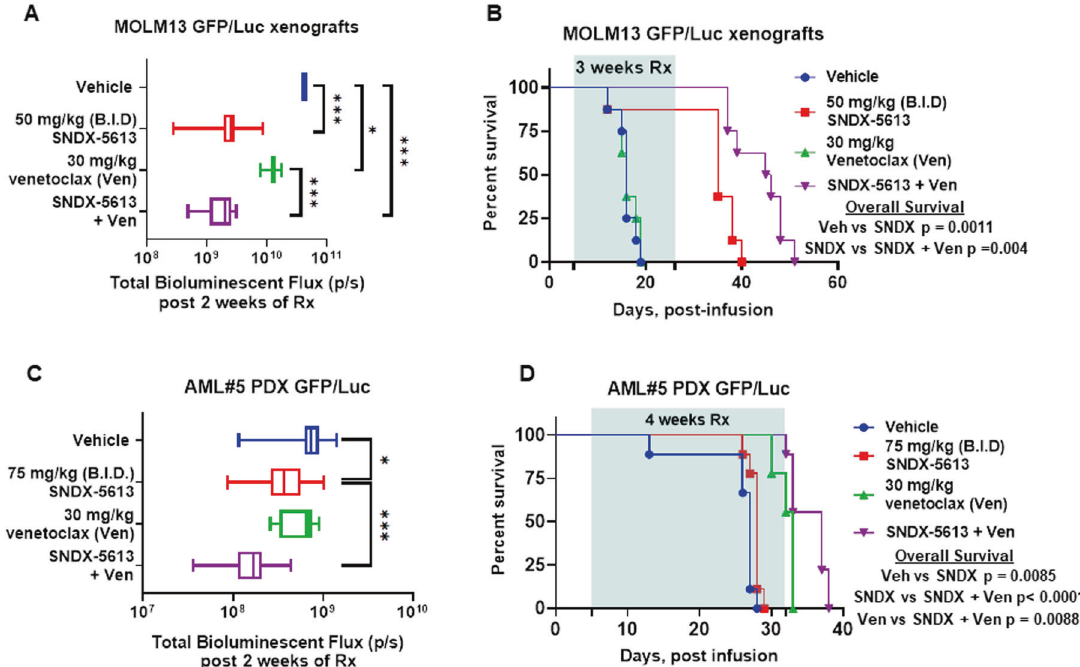
Fig. 7 Treatment with SNDX-5613 and venetoclax reduced leukemia burden and signi fi cantly improved survival of NSG mice bearing MLL1-r or mtNPM1 with mtFLT3 AML xenografts. A Total photon count [ fl ux] (determined by bioluminescent imaging) in NSG mice engrafted with MOLM13 GFP/Luc cells and treated for 2 weeks with SNDX-5613 and/or venetoclax at the indicated doses. B Kaplan – Meier survival plot of NSG mice engrafted with MOLM13 GFP/Luc cells and treated with 50 mg/kg of SNDX-5613 (B.I.D. ×5 days, P.O.) and/or 30 mg/ kg of venetoclax (daily ×5 days, P.O.) for 3 weeks. Signi fi cance was calculated by a Mantel – Cox log-rank test. C Total photon counts [ fl ux] (determined by bioluminescent imaging) in NSG mice engrafted with PD, AML blasts expressing mtNPM1, and mtFLT3 and treated with vehicle or SNDX-5613 and/or venetoclax at the indicated doses for 2 weeks. D Kaplan – Meier survival plot of NSG mice bearing a mtNPM1 and mtFLT3-expressing AML PDX and treated with 75 mg/kg of SNDX-5613 (B.I.D. ×5 days, P.O.) and/or 30 mg/kg of venetoclax (daily ×5 days, P.O.) for 4 weeks. Signi fi cance was calculated by a Mantel – Cox log-rank